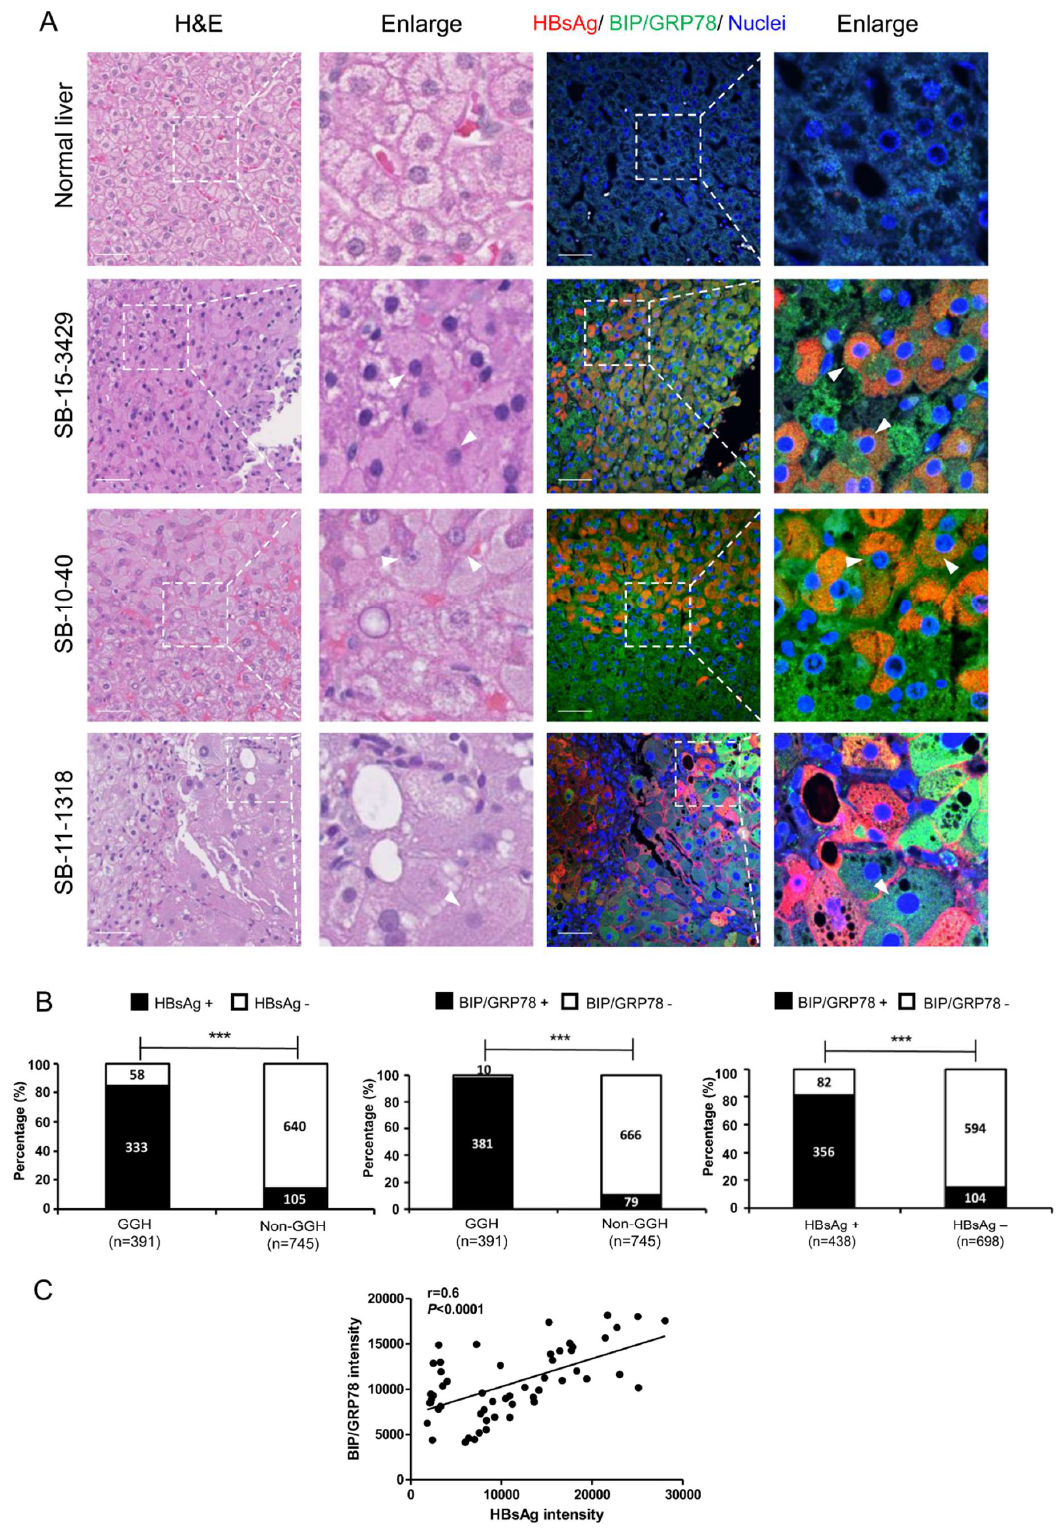
Figure 5. H&E and immunofluorescent staining of HBV-infected livers. ( A ) Paraffin-embedded liver specimens were evaluated by H&E and immunofluorescent staining. Staining of representative fields of normal liver and three HBV patients are shown. Areas with GGHs are magnified and marked (white arrowheads). HBsAg (red), BIP / GRP78 (green) and nuclei (blue) are shown. Scale bar represents 50 µ m. ( B ) Quantifications were performed based on the staining of HBV patients shown above. The ratio of HBsAg-positive to negative cells (left) or BIP / GRP78 -positive vs. negative cells (middle) is shown. Similarly, groups based on HBsAg staining and the ratio of BIP / GRP78 -positive vs. negative cells were determined (right). *** p < 0.001. ( C ) In immunofluorescent staining on liver samples from chronic hepatitis B patients, the HBsAg and BIP / GRP78 intensities in each cell were measured, and their correlation was